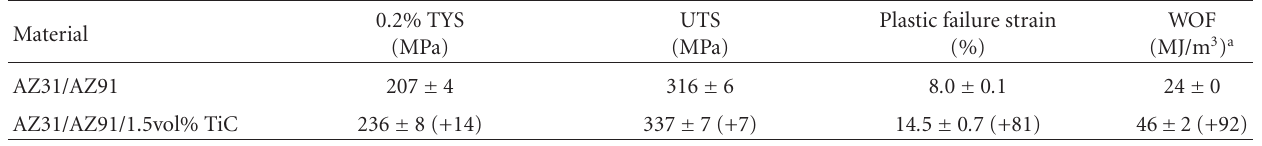
Table 3: Results of tensile testing of AZ31/AZ91 and AZ31/AZ91/TiC nanocomposite.